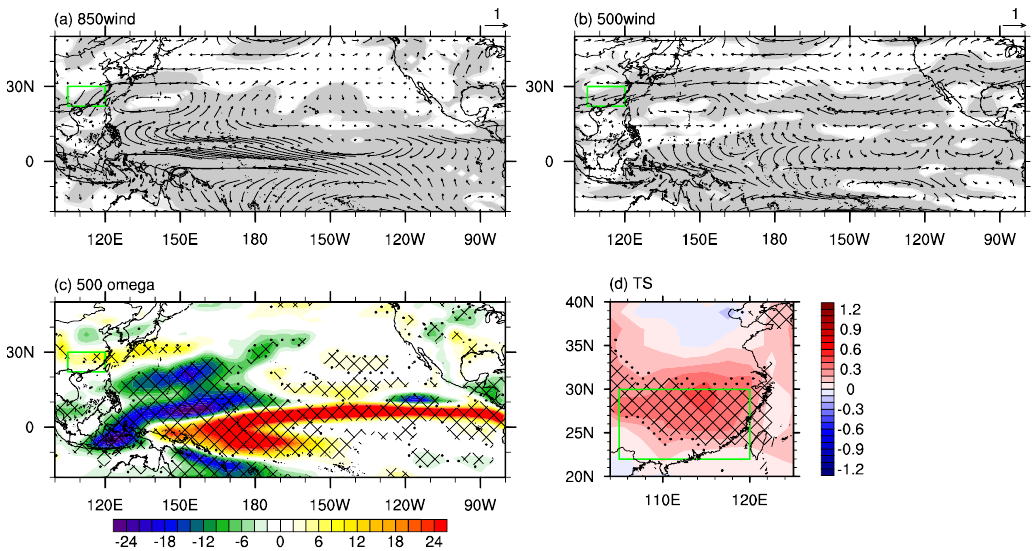
Figure 11. The differences in the summer mean ( a ) 850 hPa wind (m s − 1 ), ( b ) 500 hPa wind (m s − 1 ), ( c ) 500 hPa vertical velocity (10 − 3 Pa s − 1 ), and ( d ) surface temperature (°C) between the sensitivity experiment and the control experiment of the CAM5 model (sensitivity minus control). Light (dark) shadings in ( a , b ) and dots (meshes) in ( c , d ) denote where the anomalies are significant at the 90% (95%) confidence level based on Student’s t -test. The green rectangle in ( a – d ) refers to the domain of southern China.